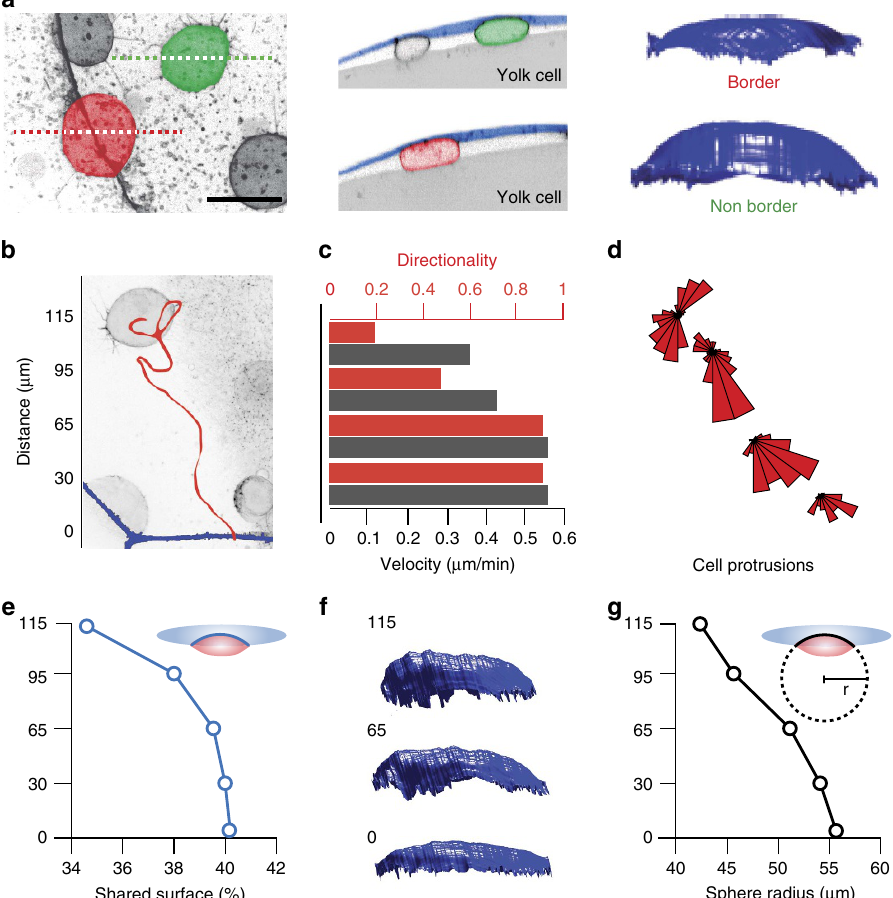
Figure 7 | Contact interactions and migratory behaviour at and away EVL cell borders. ( a ) Confocal microscopy z-stack maximum projection images with an inverted look-up table (left) and orthogonal optical sections along the depicted dashed lines (middle) of a 60% epiboly A. nigripinnis embryo expressing lifeact-GFP. DCL cells pseudocoloured in red and green are representative examples obtained from the analysis of n 4 3 embryos of cells located at and away from the EVL cell border, respectively. 3D volumetric projections of the DCL-EVL contact surface corresponding to the coloured DCL cells are shown on the right panels. ( b – g ) Changes in migratory behaviour, shared surface and EVL basal surface deformation as the DCL cell approaches the EVL cell border. ( b ) Confocal microscopy z -stack maximum projection of an embryo expressing lifeact-GFP , showing a single DCL cell that is about to move towards the EVL cell border (blue line at the bottom). The red line corresponds to the track followed by the cell as it approaches the border during a period of 45min. Numbers on the left indicate the distance to the EVL cell border (distance ¼ 0), used to define intervals for the quantifications shown in ( c – g ). ( c ) Quantification of the velocity (dark brown) and directionality (red) of DCL cell movement. ( d ) Circular plots depicting the orientation of filopodial-like membrane protrusions of the DCL cell shown in b . ( e ) Quantification of the DCL-EVL contact surface (shared surface). ( f ) 3D volumetric projections of the DCL-EVL contact surface at defined distances from the EVL border (numbers on left). ( g ) Quantification of the curvature radius ( r ) of the sphere that fits into the 3D volumetric surface area shared between the DCL cell and the EVL basal surface, as a measure of EVL basal surface deformation. ( b – g ) were obtained after analysis of Supplementary Movie